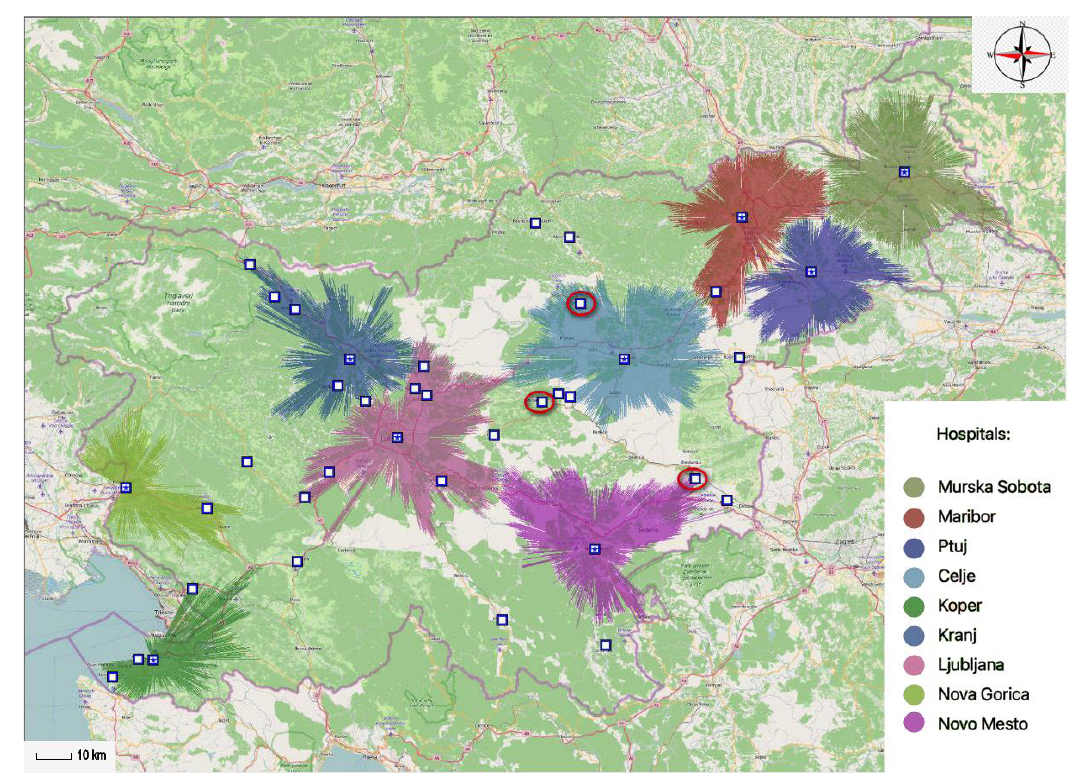
Figure 4. Optimal locations of nine different general hospitals within the 30-min time interval.